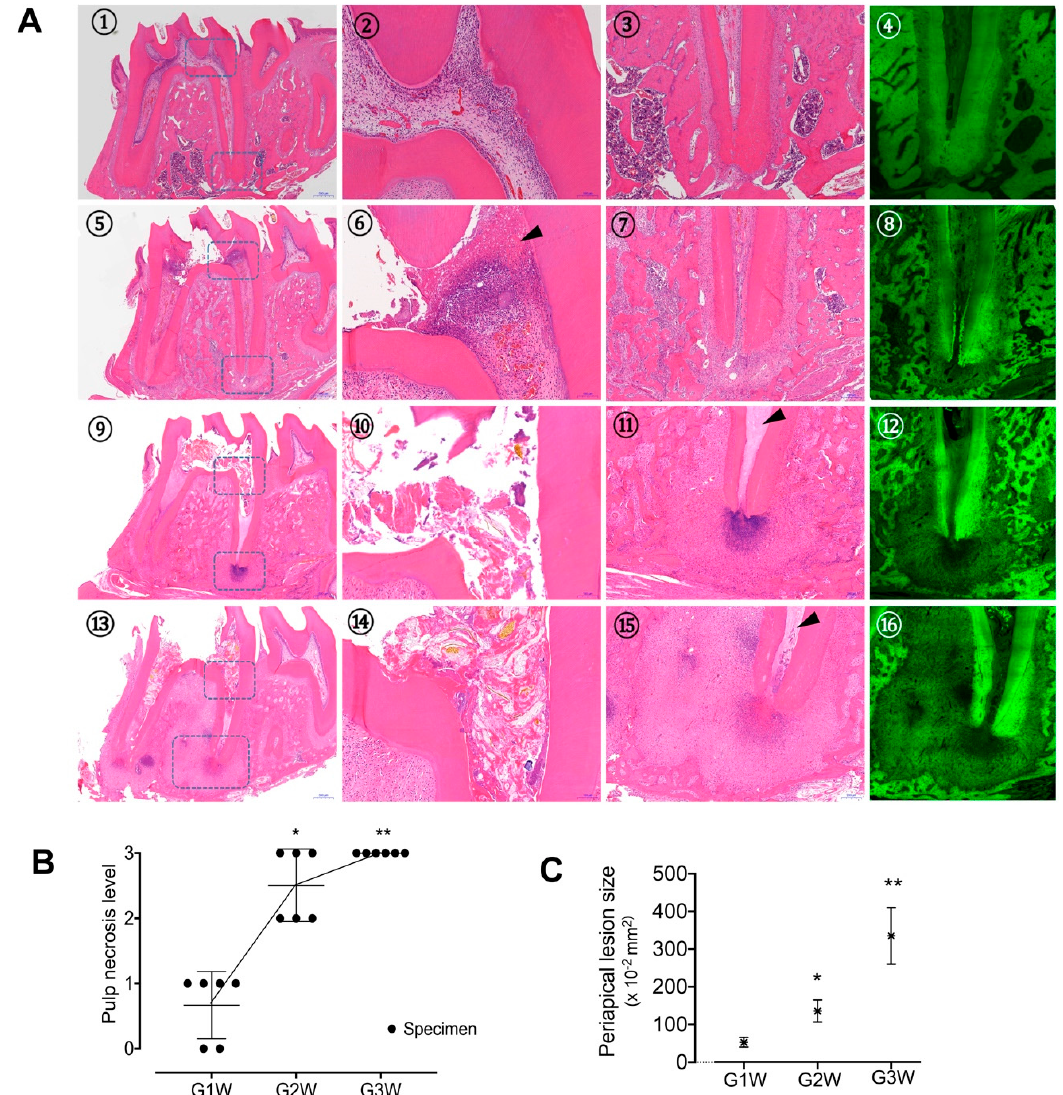
Figure 2. ( A ) Representative histologic features of the chronological changes in the pulp-exposed lower first molar of rat: whole tooth (1), magnified coronal pulp (2), magnified apical area (3), and fluorescence mode image of the apical area (4) for the control group without pulp exposure; whole tooth (5), magnified coronal pulp (6), magnified apical area (7), and fluorescence mode image of the apical area (8) at one week after pulp exposure; whole tooth (9), magnified coronal pulp (10), magnified apical area (11), and fluorescence mode image of apical area (12) at two weeks after pulp exposure; whole tooth (13), magnified coronal pulp (14), magnified apical area (15), and fluorescence mode image of apical area (16) at tree weeks after pulp exposure. The arrowhead indicates the pulp necrosis area. ( B ) Pulp necrosis level for the roots of all specimens. Here, 0 indicates pulp cells are alive in the whole root, 1 indicates partial necrosis has occurred in the coronal one-third of the root canal, 2 indicates necrosis has occurred in two-thirds of the whole root canal, and 3 indicates full necrosis of the whole root canal. * statistically significant di ff erence from the G1W group ( P < 0.05). ** statistically significant di ff erence from the G1W and G2W groups ( P < 0.05). C , The average size of the periapical lesion of the distal root for each group. * statistically significant di ff erence from the G1W group ( P < 0.05). ** statistically significant difference from the G1W and G2W groups ( P < 0.05).